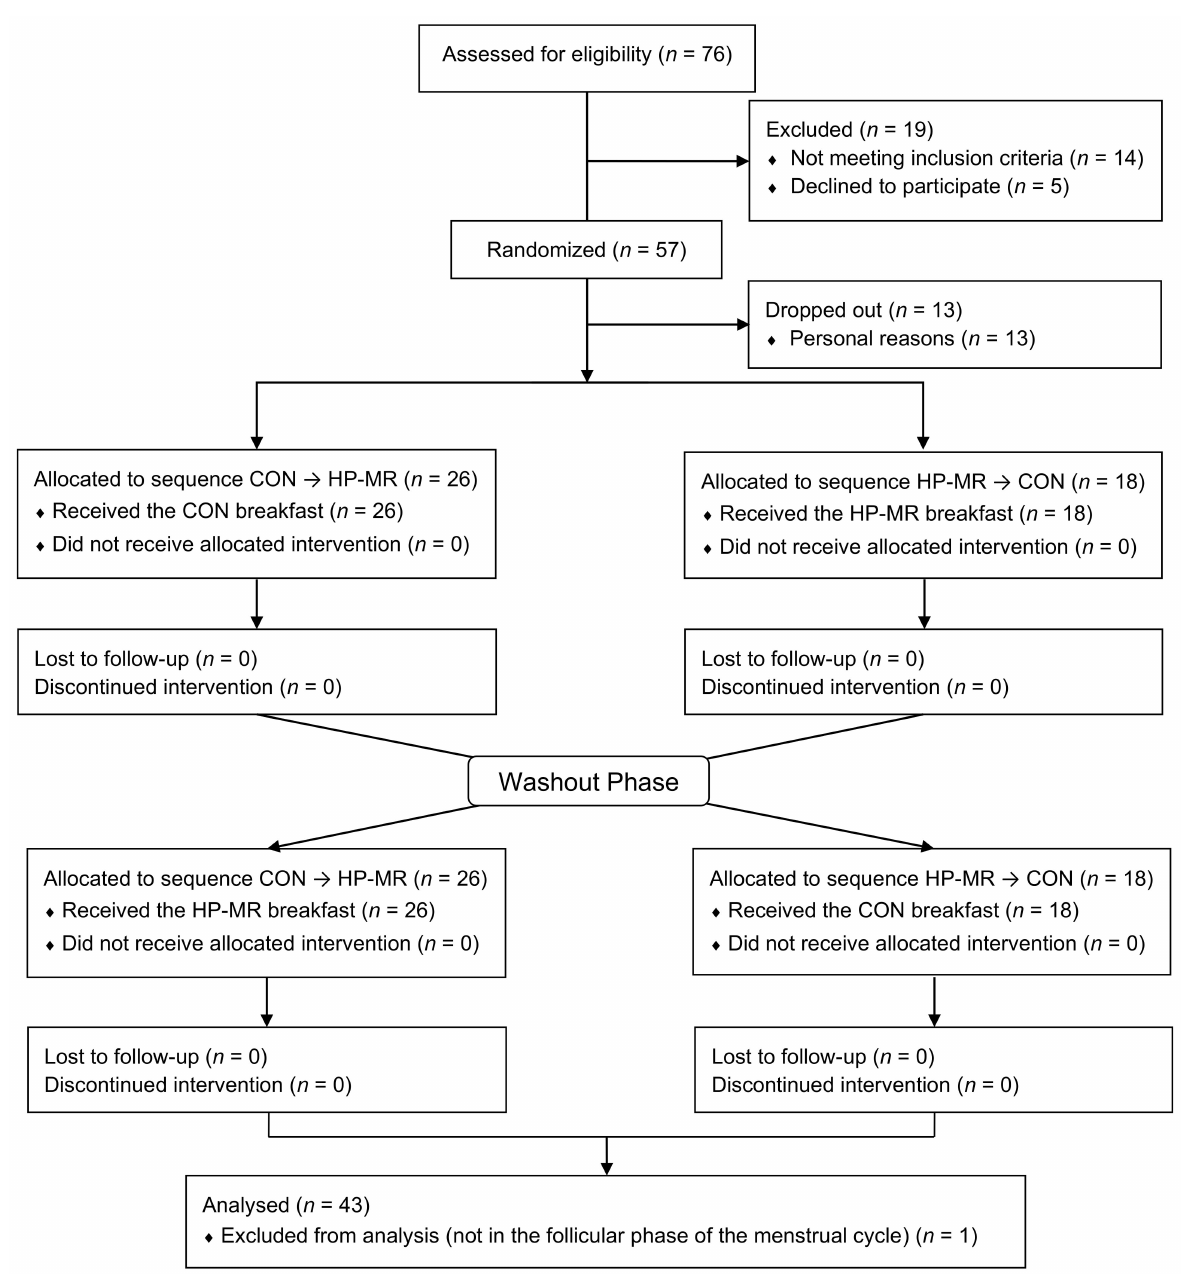
Figure 2. Baseline characteristics of participants are described in Table 2. Seventy-nine percent of participants were classified as active, 16% as moderately active, and 5% as insufficiently active.